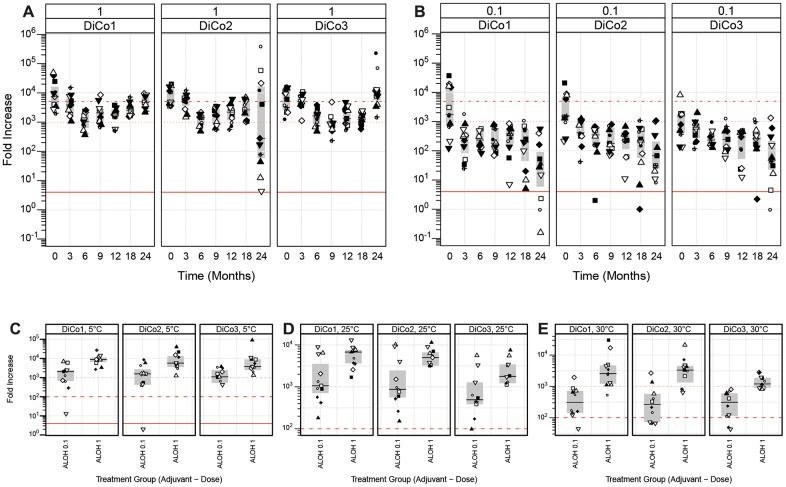
Potency of the Drug Product as a function of storage time.Panel A: Immunopotency of the drug product as a function of real-time storage time at -20°C for the high dose (1 μg Drug Product), formulated in Alhydrogel. The fold increase (seroconversion) is shown. Panel B: Immunopotency of the drug product as a function of real-time storage time at -20°C for the low dose (0.1 μg Drug Product), formulated in Alhydrogel. The fold increase (seroconversion) is shown. Panel C: Immunopotency of the formulated PfAMA1-DiCo vaccine (formulated with Alhydrogel) after storage for 24 hours at 5°C. Both dosages are shown. Panel D: Immunopotency of the PfAMA1-DiCo vaccine (formulated with Alhydrogel) after storage for 24 hours at 25°C. Both dosages are shown. Panel E: Immunopotency of the PfAMA1-DiCo Drug Product after storage for seven days at 30°C (before formulation). Immunopotency was measured as described in the Material and Methods section. Boxes indicate medians (middle) and quartile ranges (bottom and top).